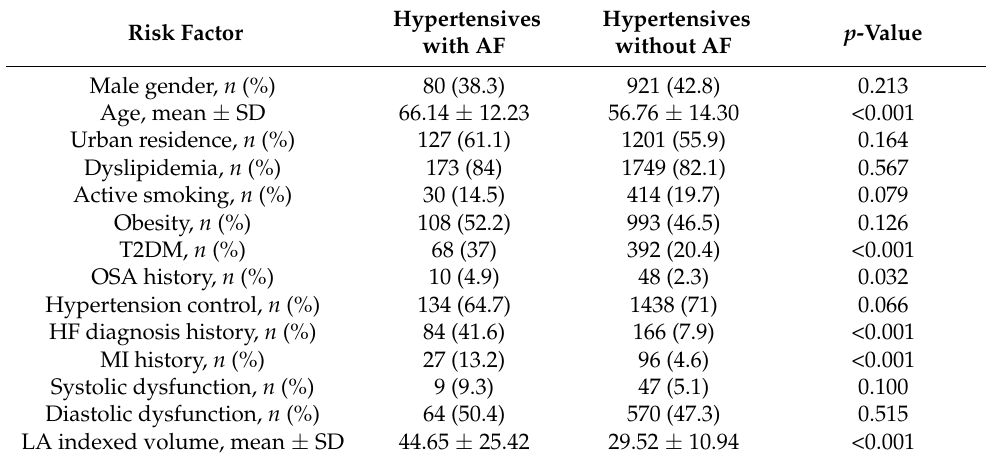
Table 2. AF-inducing risk factors in hypertensive subjects with atrial fibrillation and hypertensive subjects without atrial fibrillation. T2DM = type 2 diabetes mellitus, OSA = obstructive sleep apnea, HF = heart failure, LA = left atrium, AF = atrial fibrillation, MI = myocardial infarction.